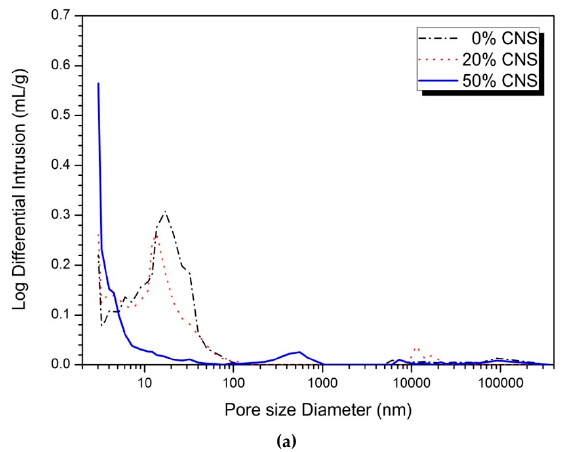
Figure 5. XRD analysis of hydration reactants: ( a ) 1-day, 5% activator samples ( b ) 28-day, 5% activator samples, ( c ) 1-day, 10% activator samples, ( d ) 28-day, 10% activator samples. M is monosulfate, C is calcite, CSH is C-S-H gel, Ht is hydrotalcite, Q is quartz, A is akermanite, S is